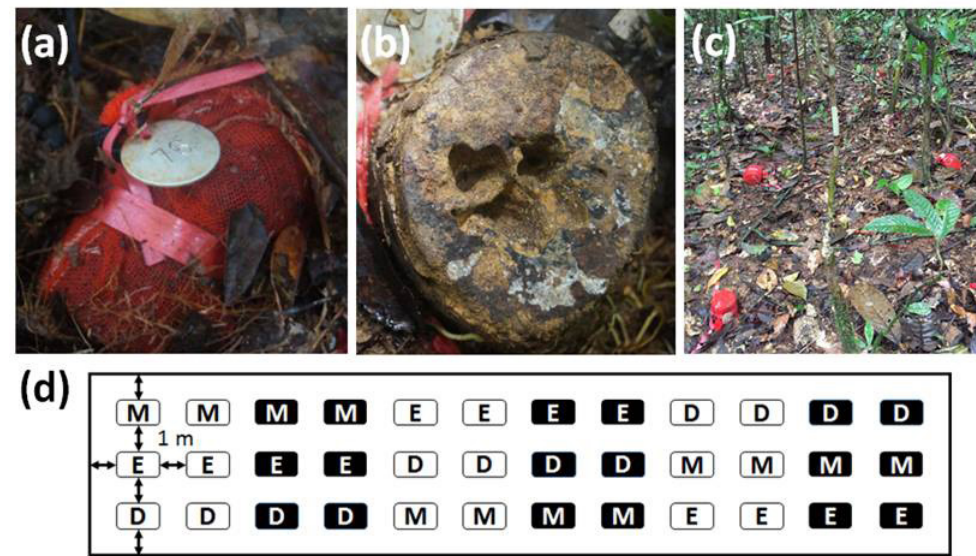
Fig 1 . Photographs of Dillenia beccariana installed as (a) a mesh bag sample, and (b) a control sample in Jul., 2016 (after 18 months), and (c) a picture of the study site, and (d) a diagram of an experimental design of each subplot in Jan., 2015. Species: M = M. bancana ; E = E. tapos ; D = D. beccariana . Treatment: white box = control; black box = mesh